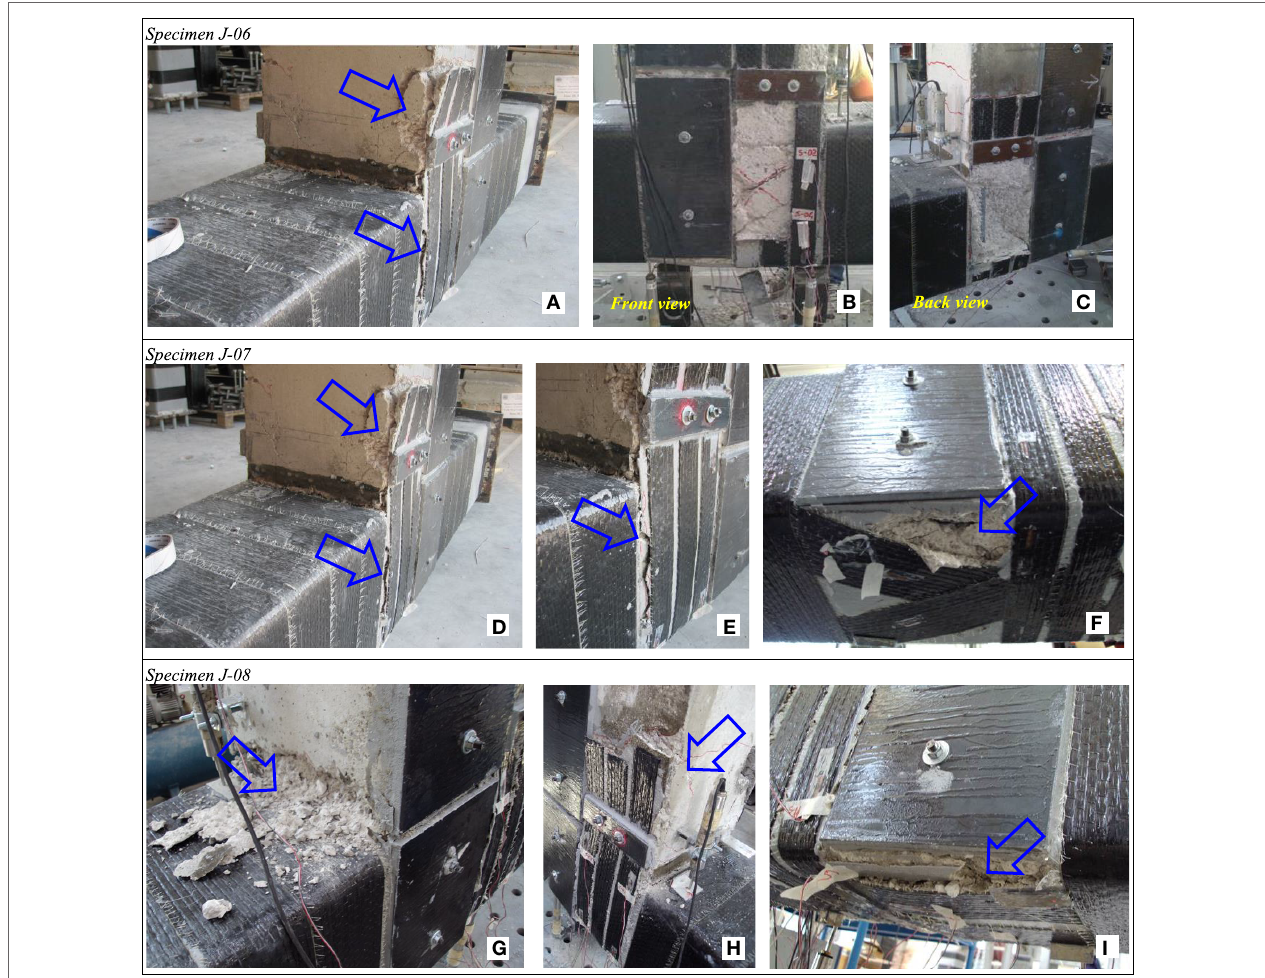
FIGURE 7 | Crack pattern and failure for CFRP strengthened specimens: J-06 (A–C) ; J-07 (D–F) ; J-08 (G–I)